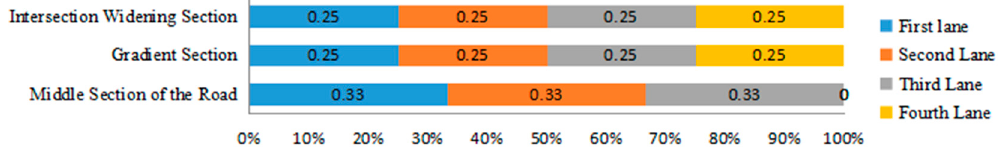
Figure 5. Percentage of FCD per lane.